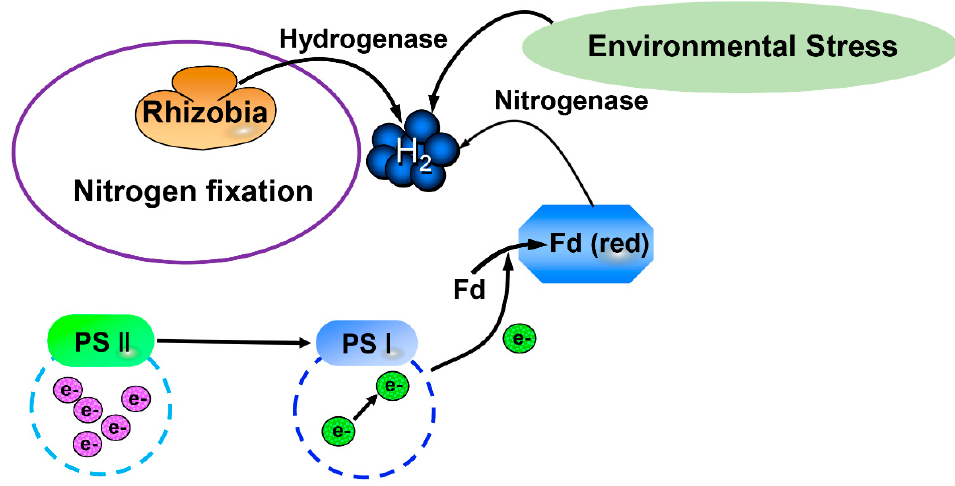
Figure 1. H 2 production pathway in organisms. H 2 , Hydrogen gas; Fd, Ferredoxin; PS II, Photosyn- thetic system II; PS I, Photosynthetic system I.